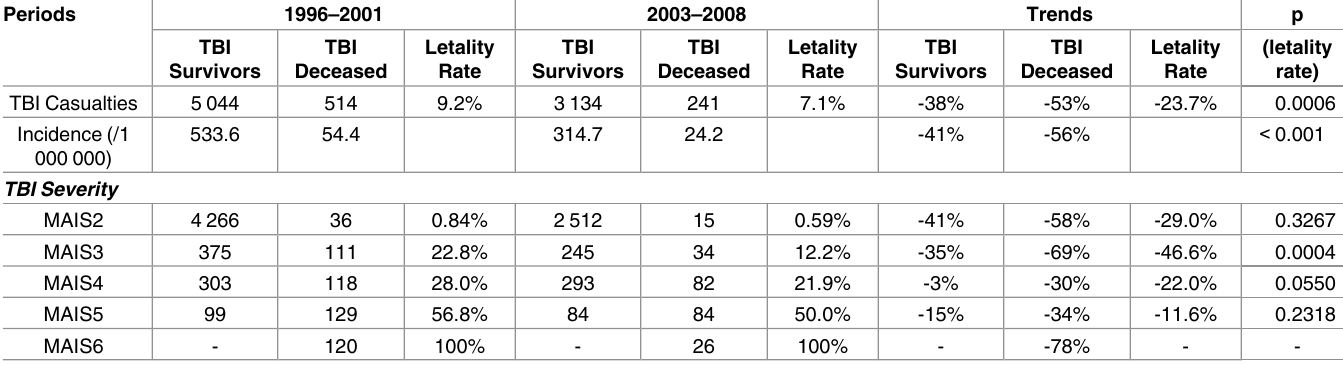
Table 2. Trend of the figures, incidence, mortality and lethality rates among RTC-related TBI victims between the two observation periods